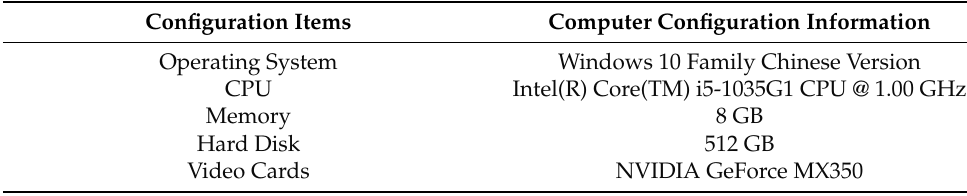
Table 1. Introduction to running environment configuration.